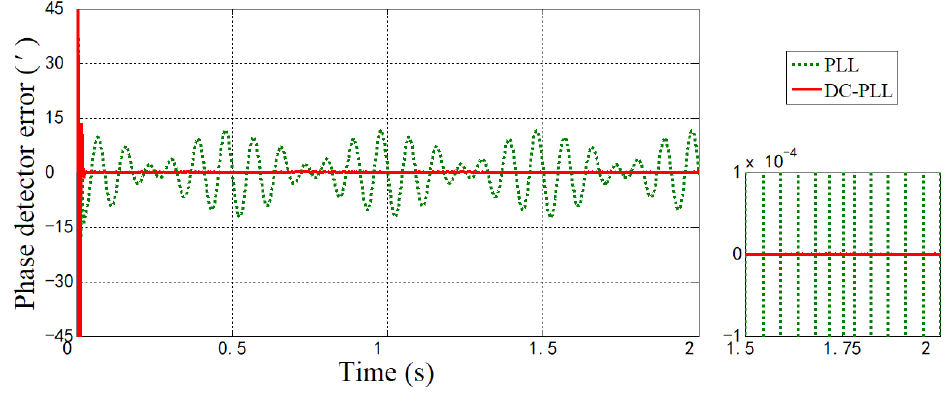
Figure 6. Phase detector error at fixed speed.